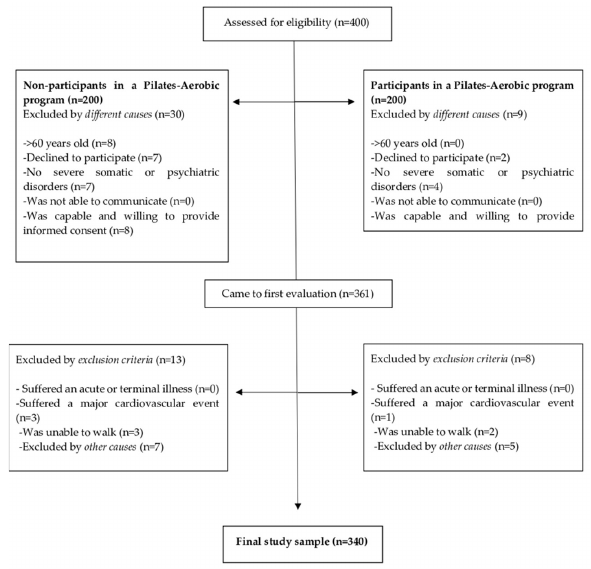
Figure 2. Participant’s flow diagram.